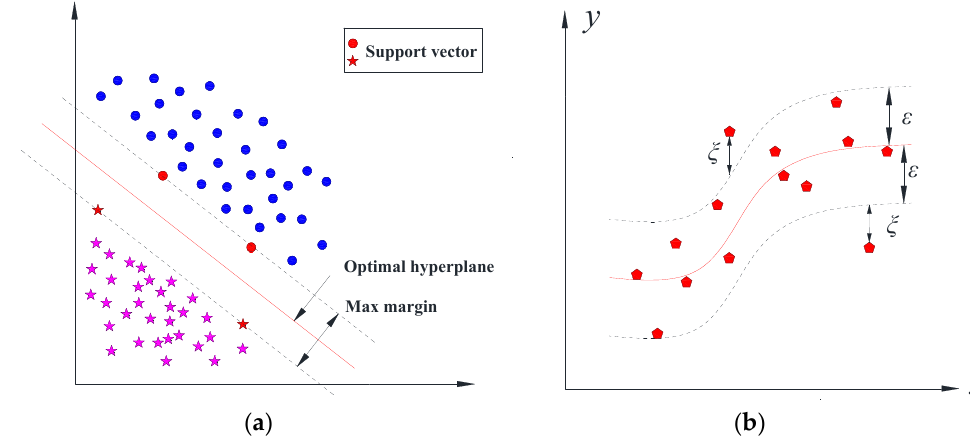
Figure 1. Support vector machine: ( a ) optimal hyperplane for classification and ( b ) SVM for regression [65]. For n sets of input data ( x i , y i )( x i ∈ X ⊆ R n , y i ∈ Y ⊆ R ) , they can be labeled